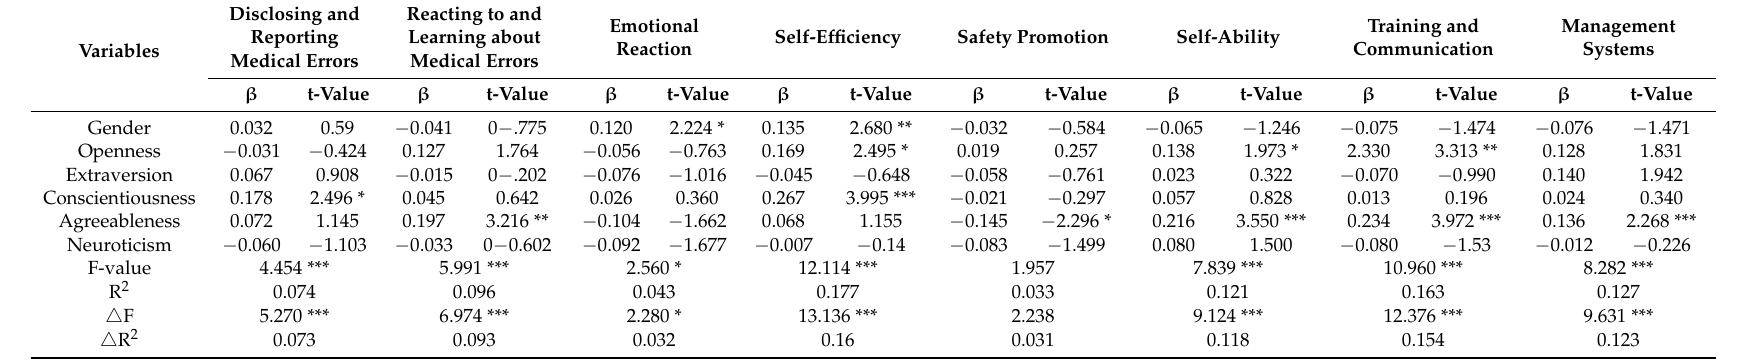
Table 3. Regression between the attitude of medical error and medical students’ personality traits for combined data with n =